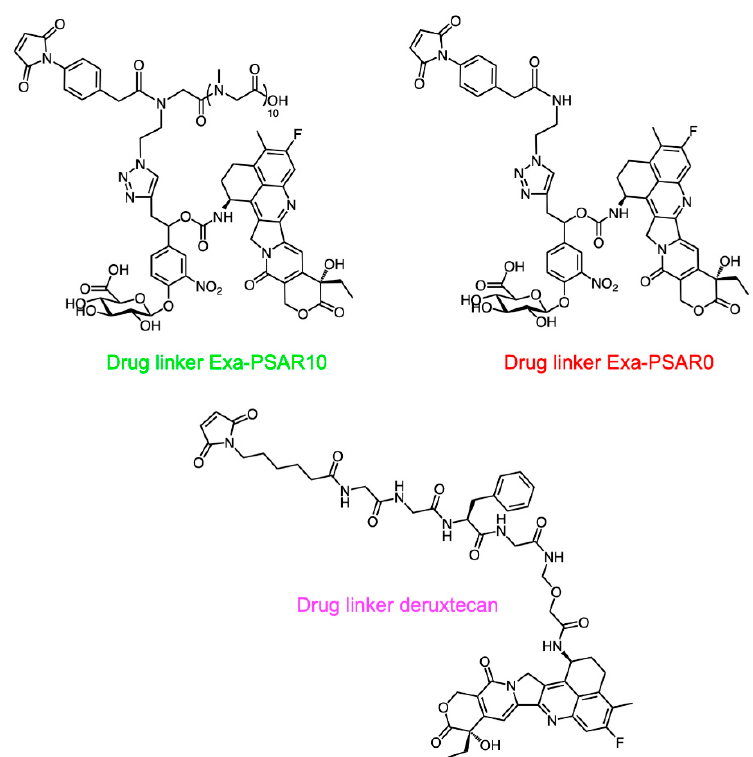
Figure 1. Chemical structures of the antibody-drug conjugates (ADC) drug-linkers used in the present study. See Supplementary Materials for detailed chemical synthetic procedures and exact ADC structures.